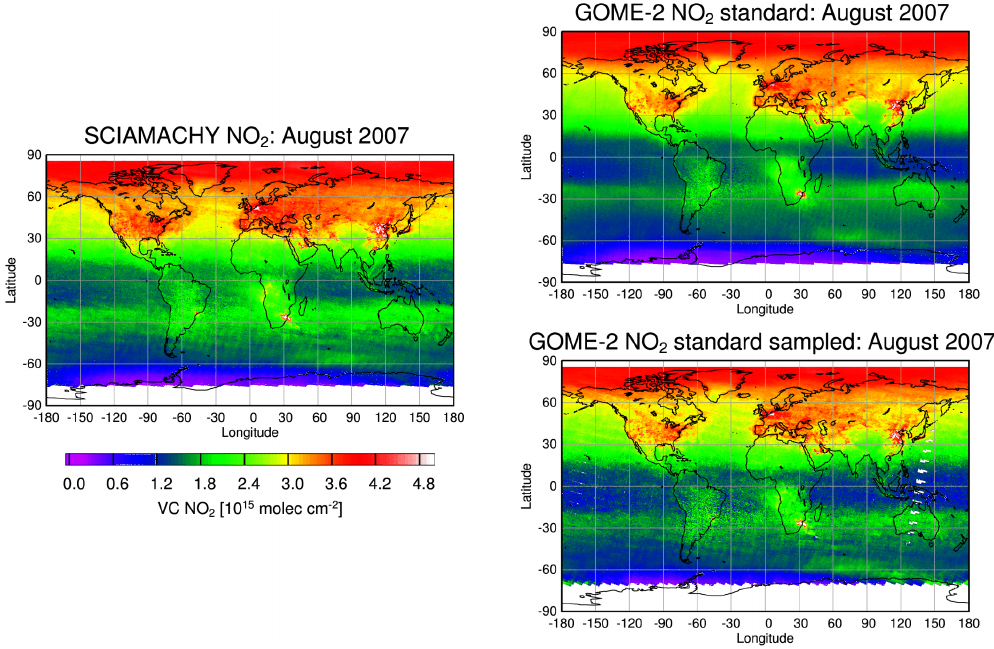
Fig. 1. Comparison of SCIAMACHY (left) and GOME-2 standard product (right) NO 2 monthly average for August 2007. A stratospheric airmass factor has been applied and only forward scan pixels with solar zenith angles below 90 ◦ have been used. No cloud screening was applied. In the upper GOME-2 figure, all data are shown, while in the lower figure, only values were used, where a corresponding SCIAMACHY value was available on the same day. As SCIAMACHY data have not been filtered in the same way, some sampling differences still